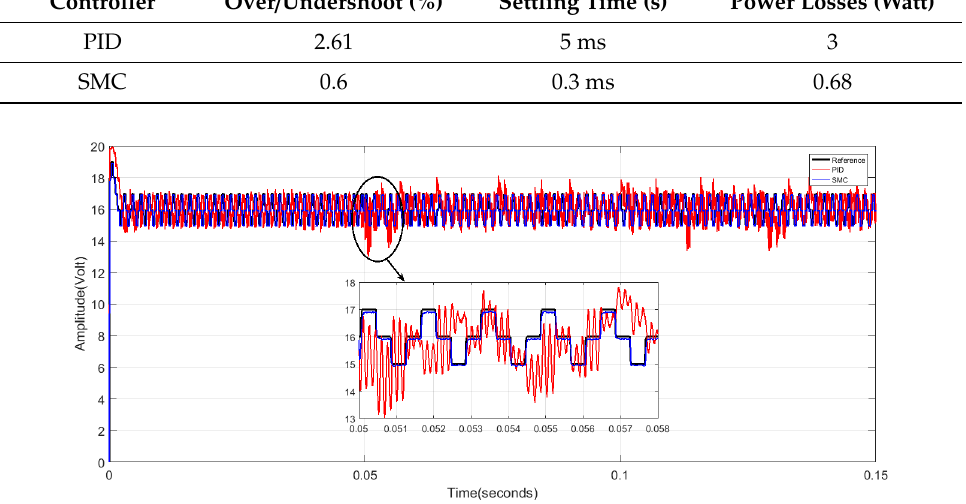
Figure 7. Reference, PID, and SMC PV voltage